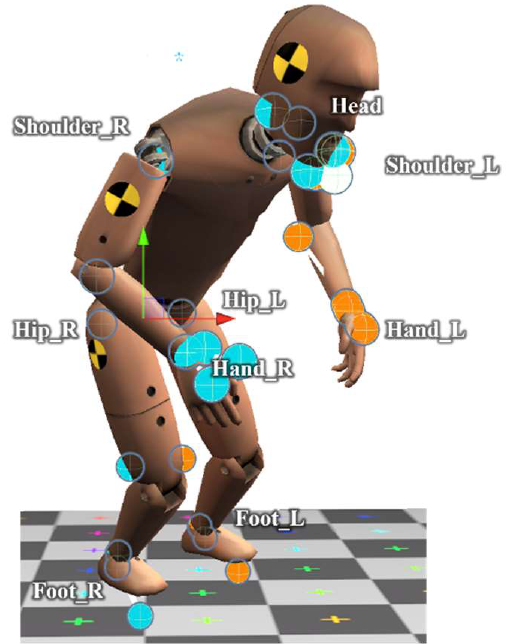
Figure 16. Angle GUI of the joint through the linked IK model.